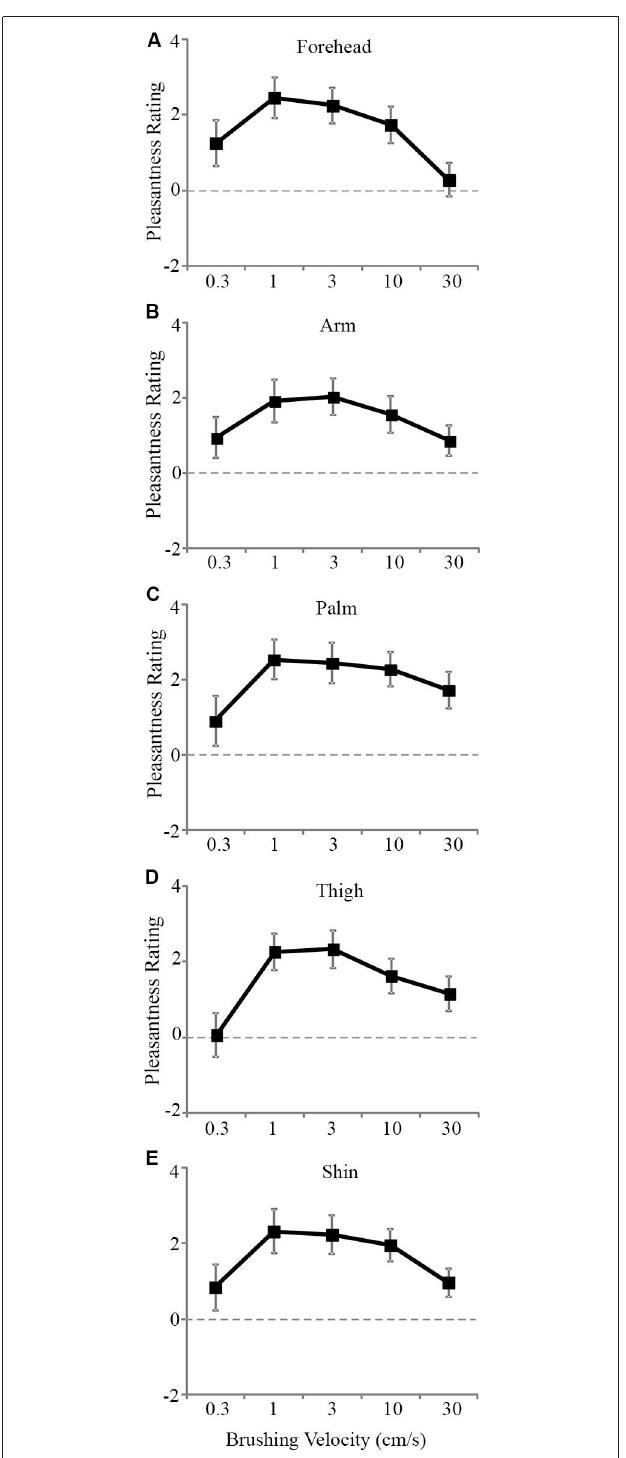
FIGURE 2 | The mean scores for pleasantness ratings at different stroking velocities over the skin sites. A significant effect of stroking velocity overall the skin sites. The slowest (0.3 cm s − 1 ) and fastest (30 cm s − 1 ) were rated as less pleasant compared to the middle velocities (1–10 cm s − 1 ) for the (A) forehead, (B) arm, (C) palm, (D) thigh, and (E) shin. The ratings scale was from − 10 to +10. Error bars correspond to ± S.E.M.